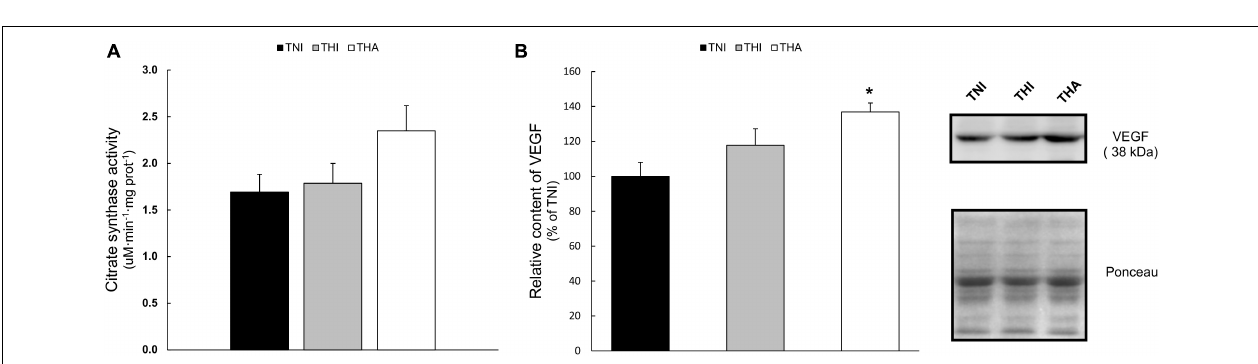
FIGURE 6 | Effects of IHH and IHH+LAE on the (A) CD, (B) FD, and (C) C/F ratio in three TA muscle regions from trained rats. ∗ and ∗∗ indicate P < 0.05 and P < 0.01, respectively, compared to TNI rats, while † indicates P < 0.05 compared to THI rats.